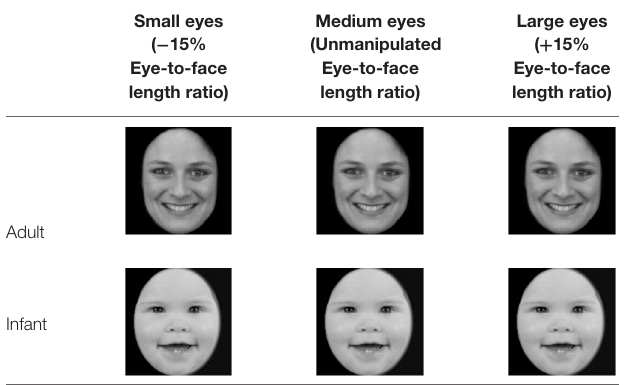
TABLE 3 | Example